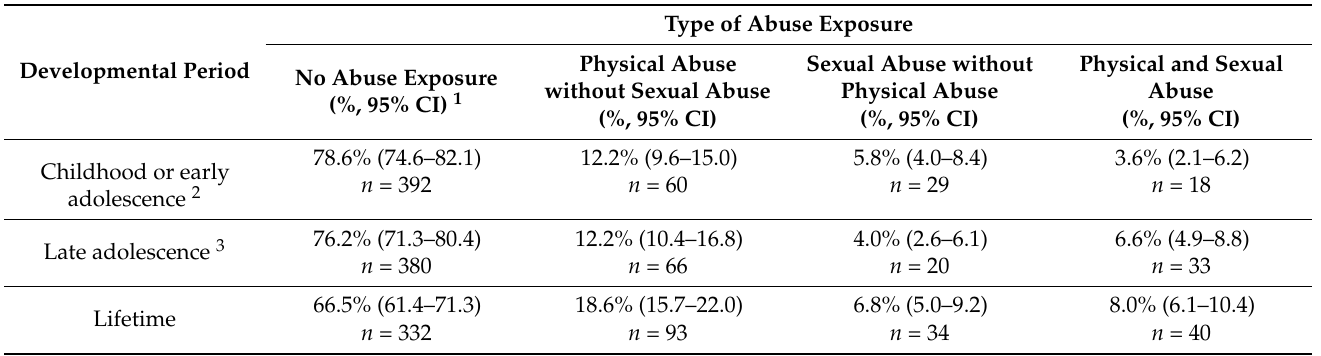
Table 1. Prevalence of physical and sexual abuse among young women who use substances in Cape Town, South Africa ( n = 499).